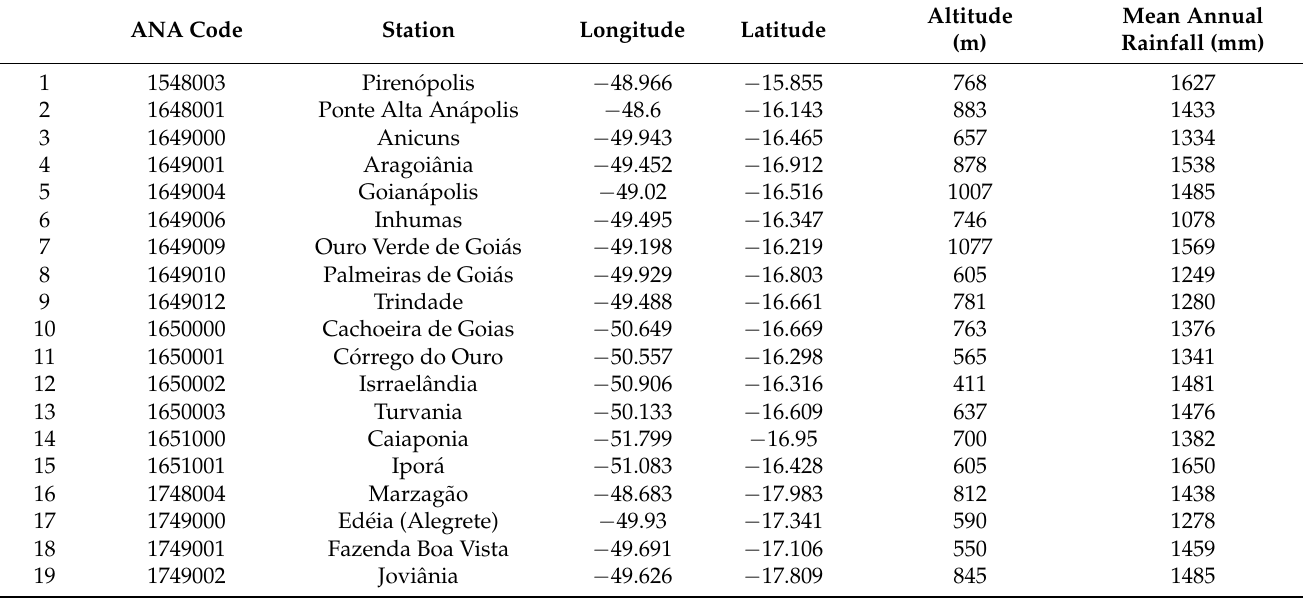
Figure 1. Study area and location rainfall gauging stations utilized in this study. Table 1. Rainfall gauging stations utilized in the